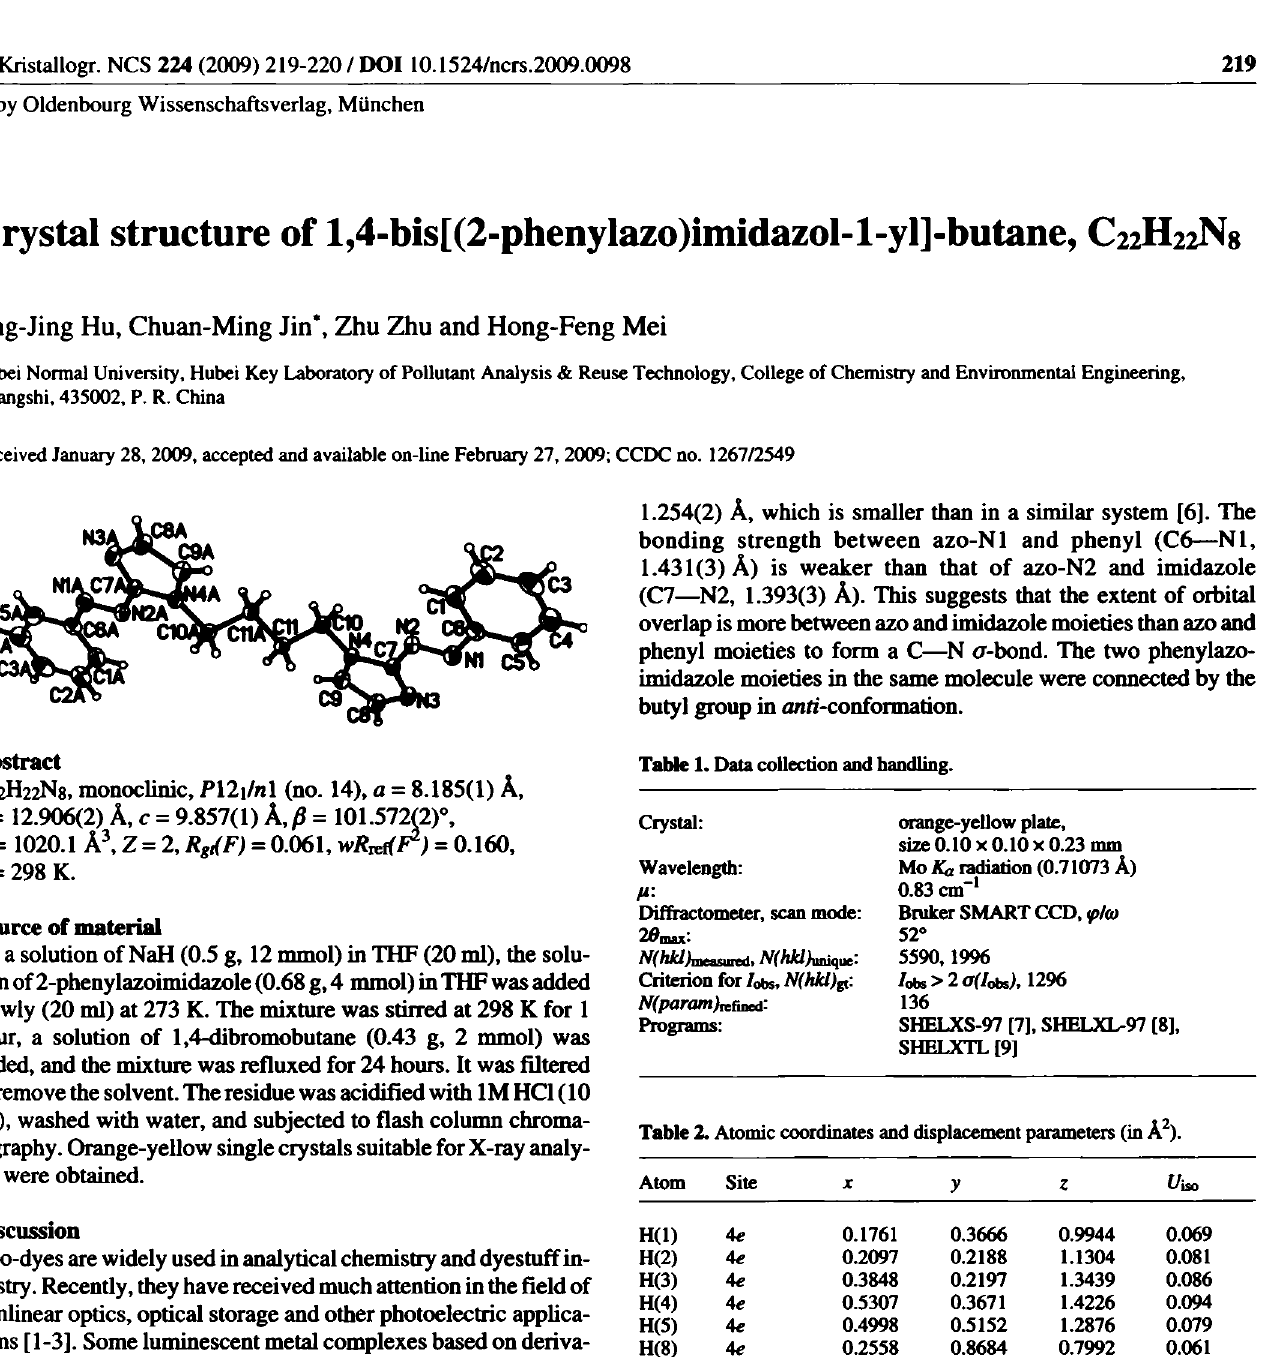
Table 3. Atomic coordinates and displacement parameters (in Â 2